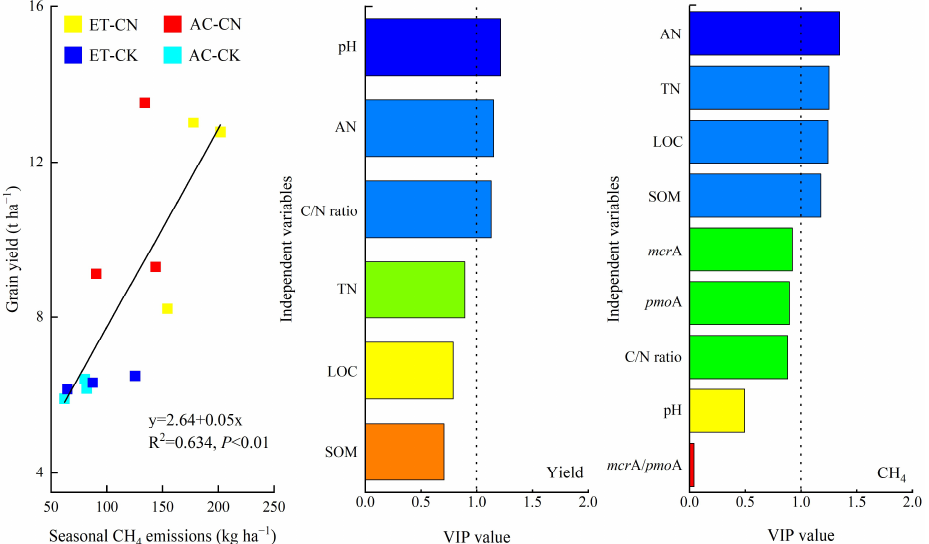
Figure 2. Correlation between cereal yield and paddy CH 4 emissions and the variable importance for the projection (VIP) values of independent variable effects on rice yield and methane emission (cut-off value with 1.0).